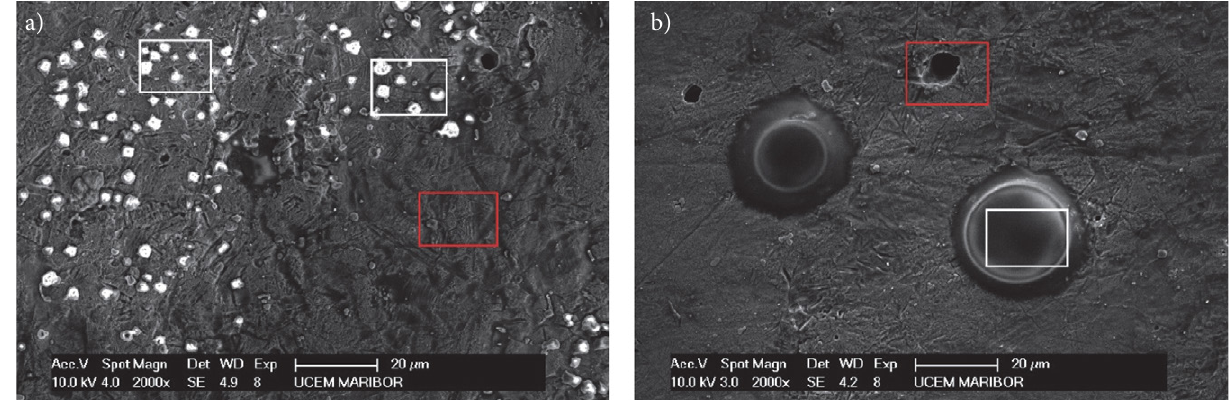
Figure1. SEM images for AISI 347 at 50 °C and pressure a) 100 bar, b) 300 bar.